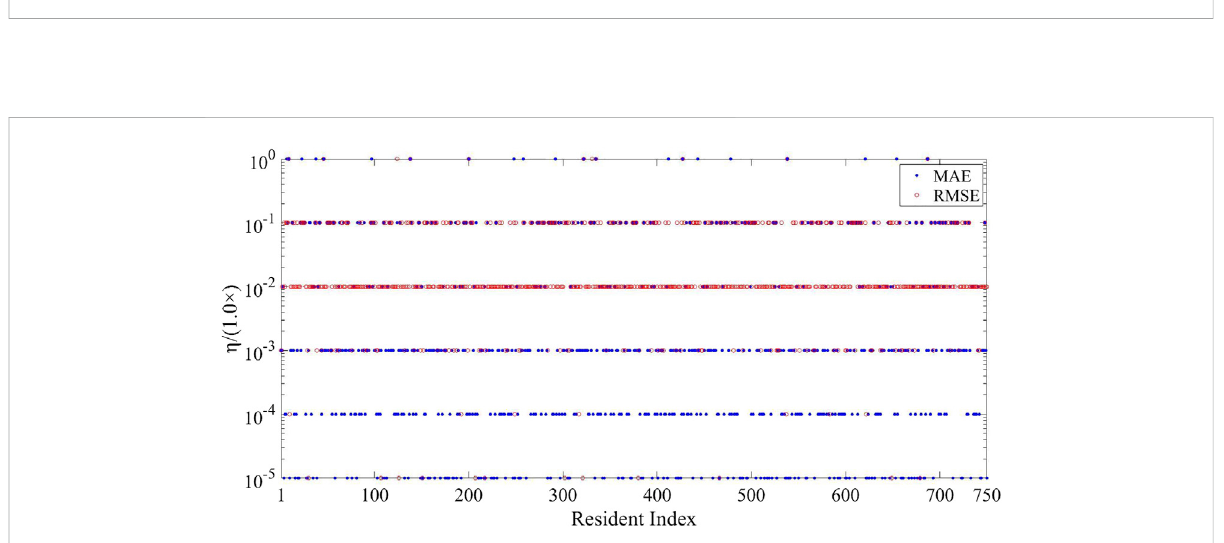
FIGURE 6 Optimal values of parameter η for the proposed method to achieve the minimum RMSE and MAE